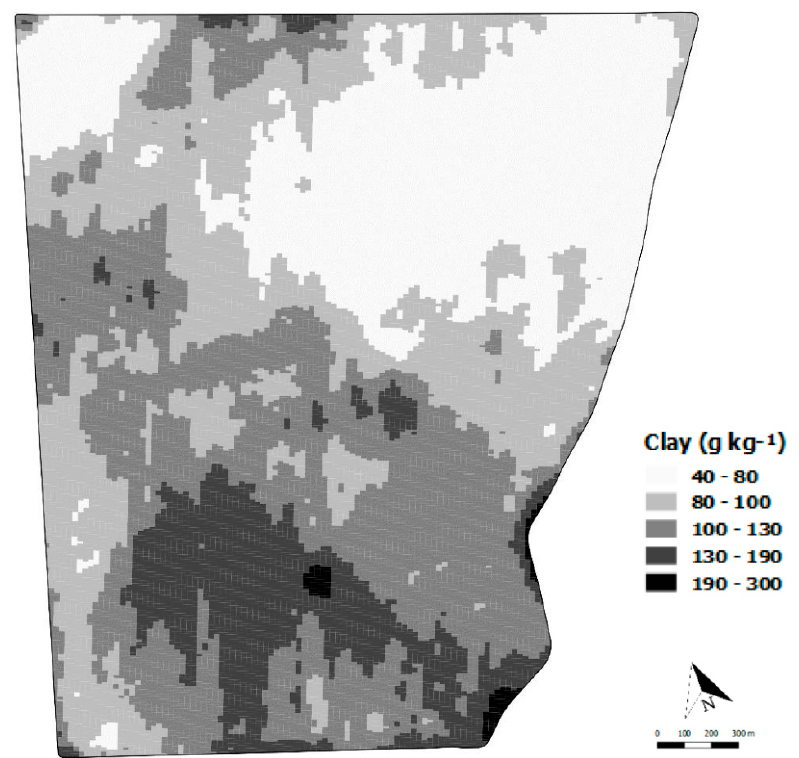
Figure A5. Spatial distribution of clay content in field NF2.